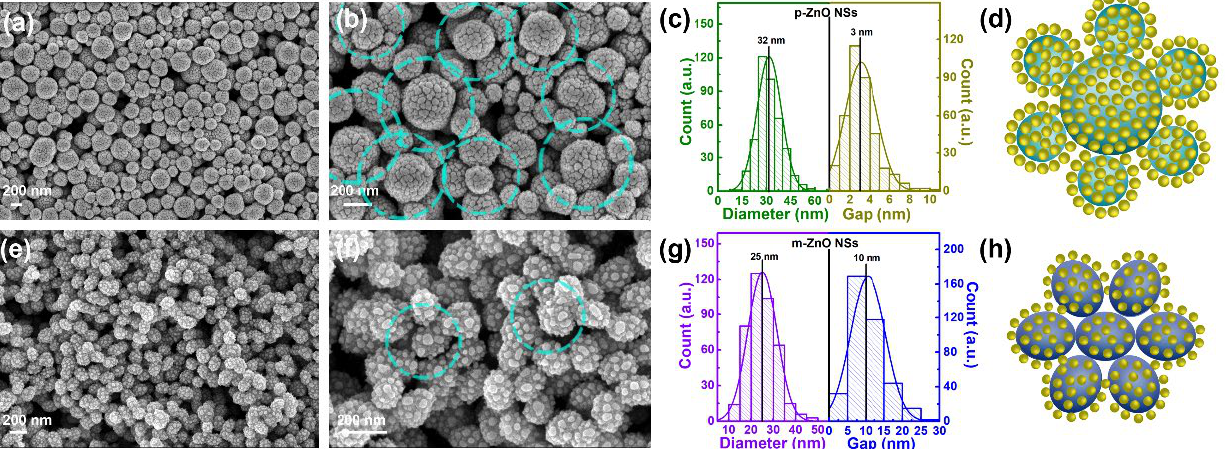
Figure 3. SEM images of p-ZnO NSs/Ag NPs ( a , b ) and m-ZnO NSs/Ag NPs ( e , f ). Statistical values for the diameters of Ag NPs and gaps between adjacent Ag NPs on the surface of the p-ZnO NSs ( c ) and the m-ZnO NSs ( g ). Schematic diagram of p-ZnO NSs/Ag NPs ( d ) and m-ZnO NSs/Ag NPs ( h ).